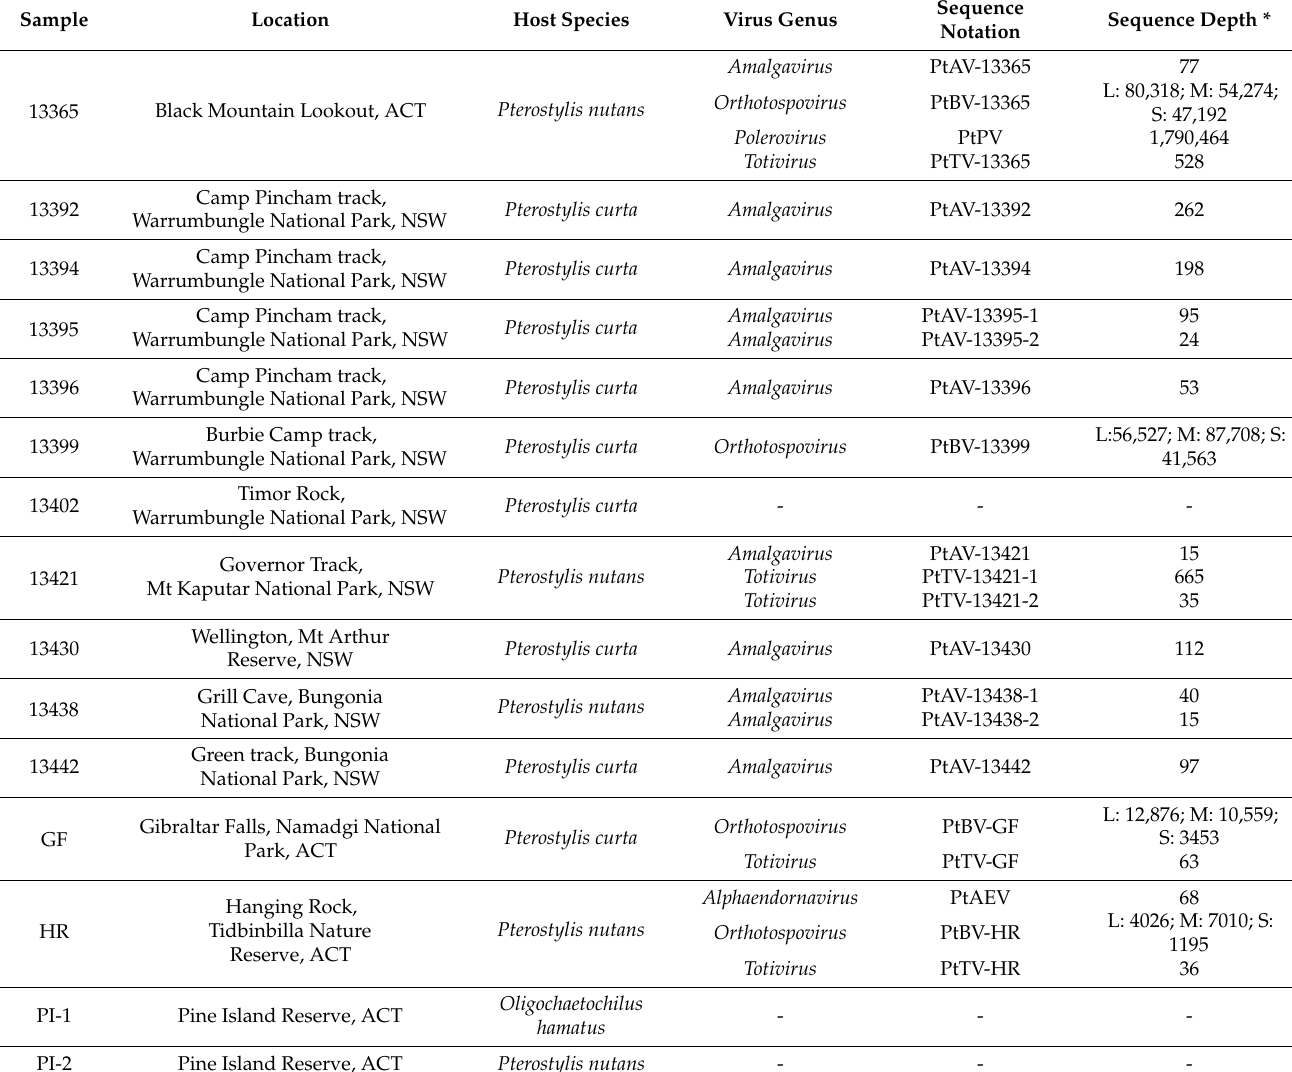
Table 1. Orchid Samples Analysed and Types of Viruses